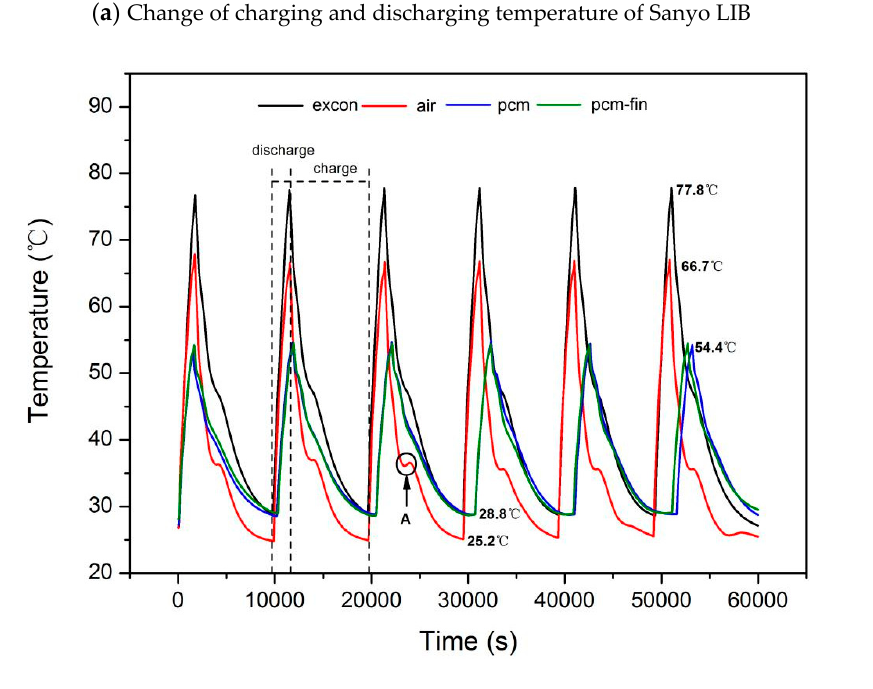
Figure 3. The temperature changing of LIBs during charging and discharging.